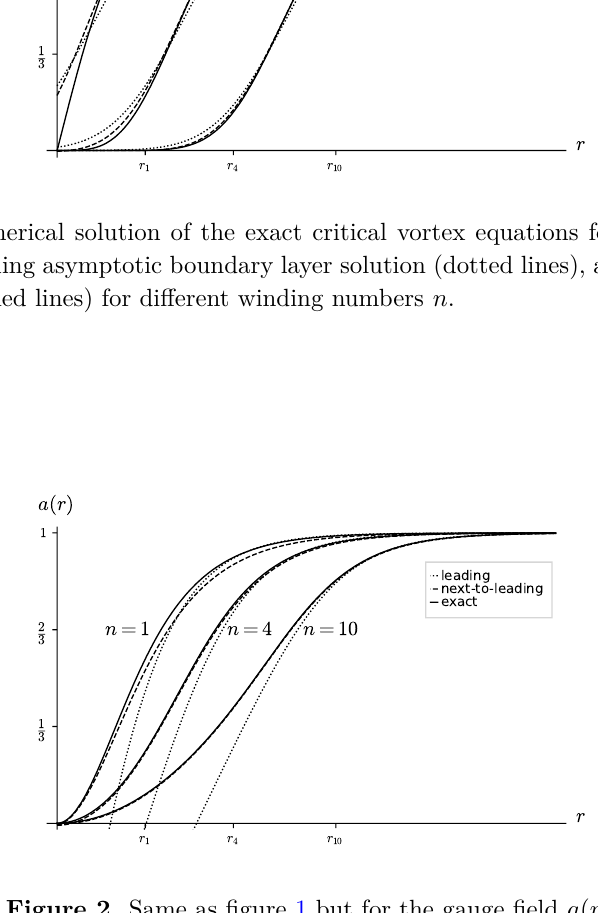
Figure 2 . Same as figure 1 but for the gauge field a ( r )